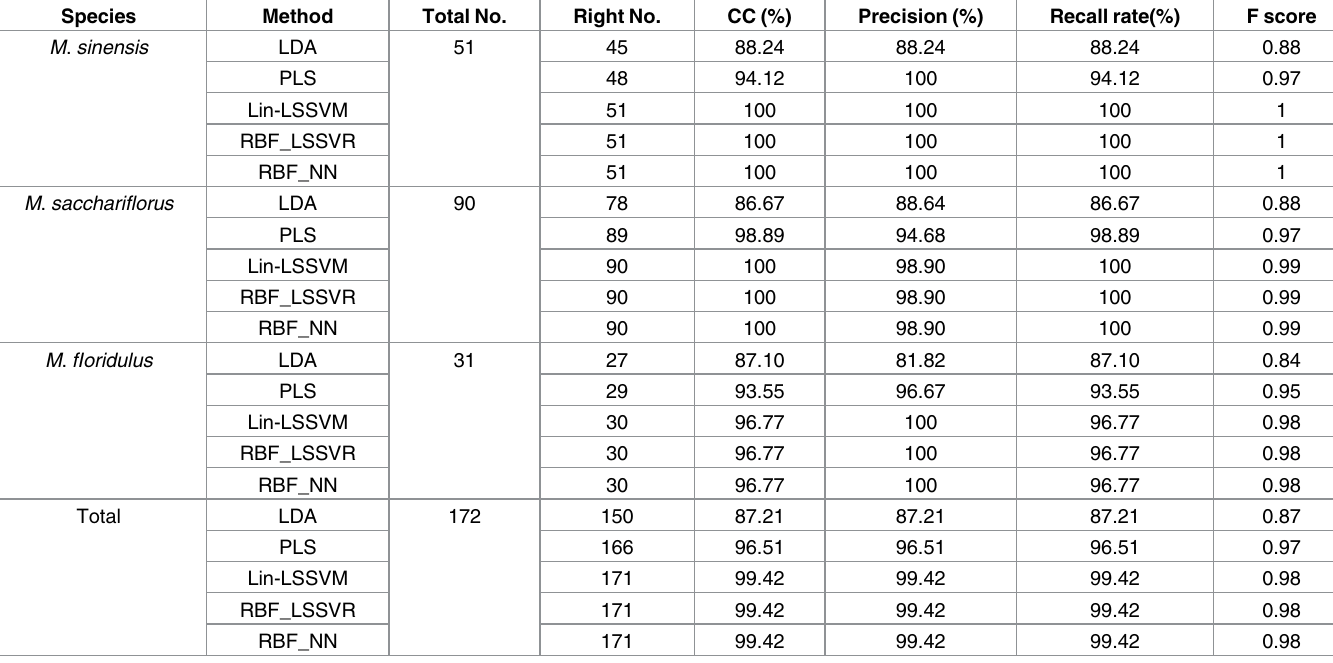
Table 3. Classification of Miscanthus accessions using LDA, PLS, LS-SVM, RBF_LSSVR and RBF_NN. Species